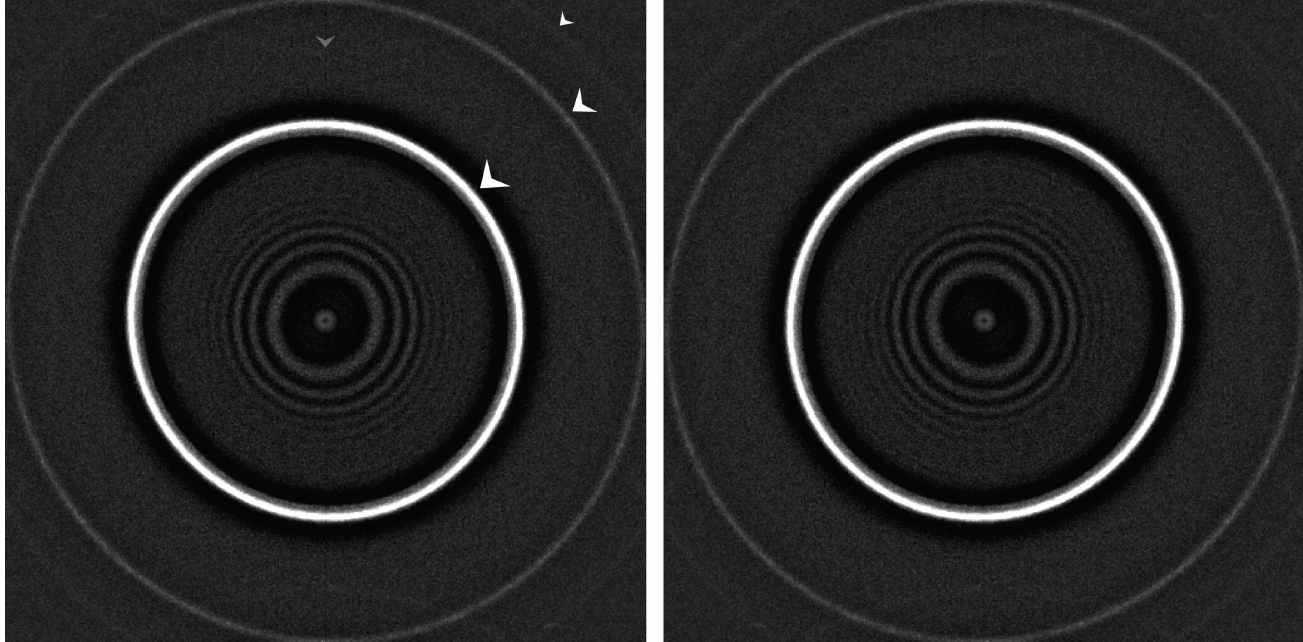
Figure 2 Anisotropic magnification of the worm-haemoglobin data set became evident from an eigenvector analysis of all amplitude spectra (see x 2.5). The second eigenimage revealed a 2.6% ellipticity of the (cid:2) 3.6 A ˚ water ring (marked with large arrow in the left spectrum) and the 2.2 A ˚ water ring (medium- sized arrow). A further water/ice ring can be seen at 1.8 A˚ (small arrow), which is only visible in the corners of the image (beyond the Nyquist frequency) but reflects back into the image everywhere else owing to aliasing (grey arrow). The right spectrum is the same as the left spectrum but is mirrored horizontally, thus changing the ellipticity direction. The ellipticity is in a close-to-diagonal ( (cid:2) 36 (cid:5) ) direction such that the vertical and horizontal magnifications in the data set are almost identical. The Thon rings visible in the centre are elliptical owing to an astigmatism of (cid:2) 1000 A˚ . This astigmatism ellipticity is unrelated to the ellipticity of the water rings. The two effects may become entangled if the anisotropic magnification is not corrected prior to CTF